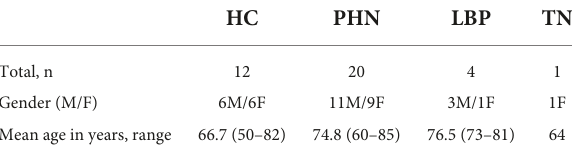
TABLE 1 Baseline characteristics of healthy controls and patients with PHN, LBP, or